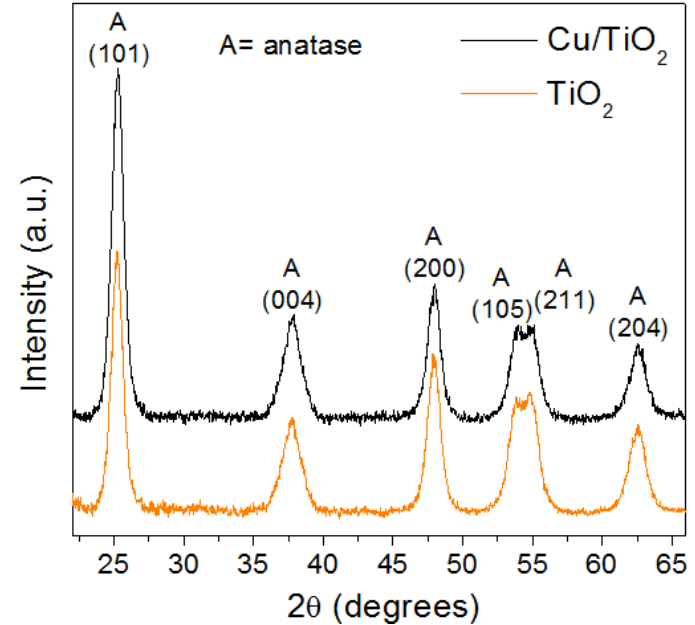
Figure 2. X-ray diffraction patterns of the synthesized Cu/TiO 2 and TiO 2 catalysts. Table 3. Structural properties of Cu/TiO 2 and TiO 2 catalysts.